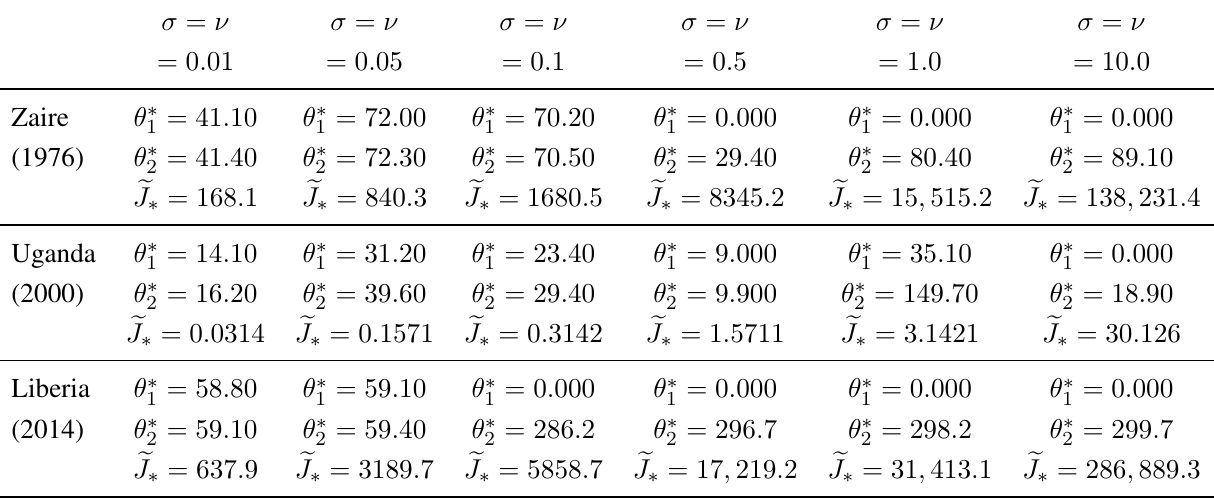
Table 2. Dependence of the optimal switchings θ ∗ parameters σ , ν .